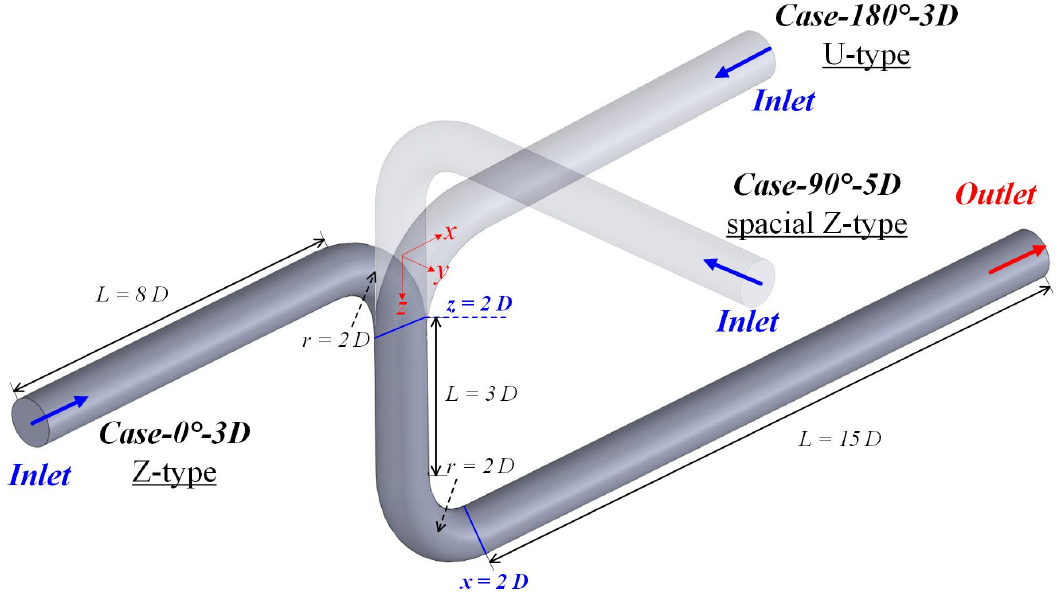
Figure 1. Computational domain of double-curved pipe.